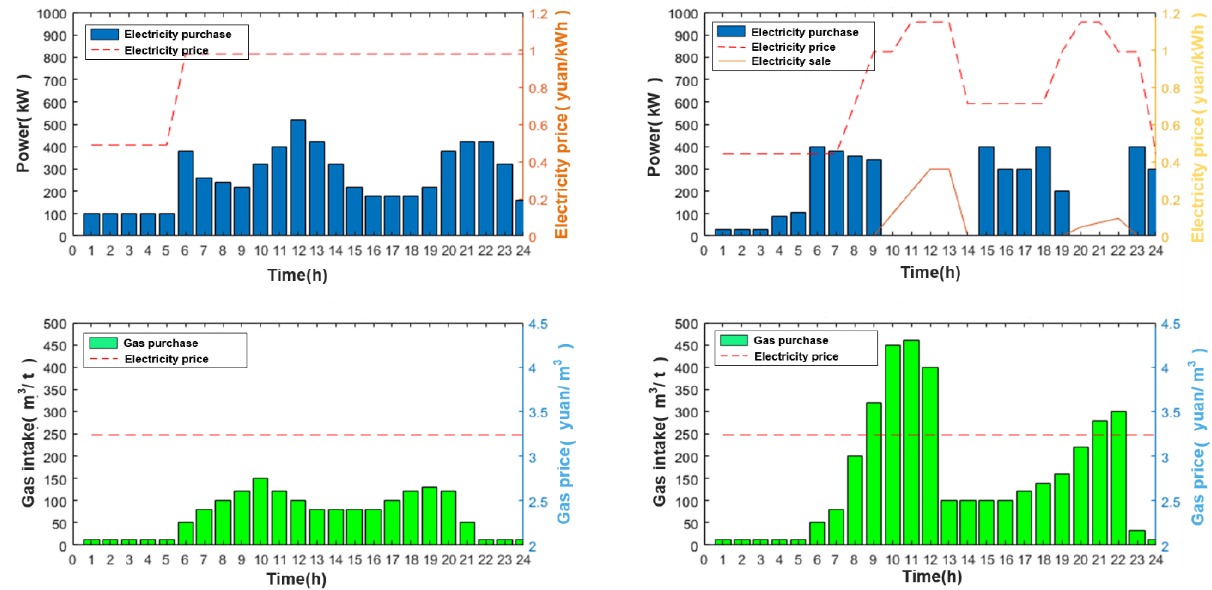
Figure 10. Comparison before and after interaction between the commercial building and electricity market in winter.